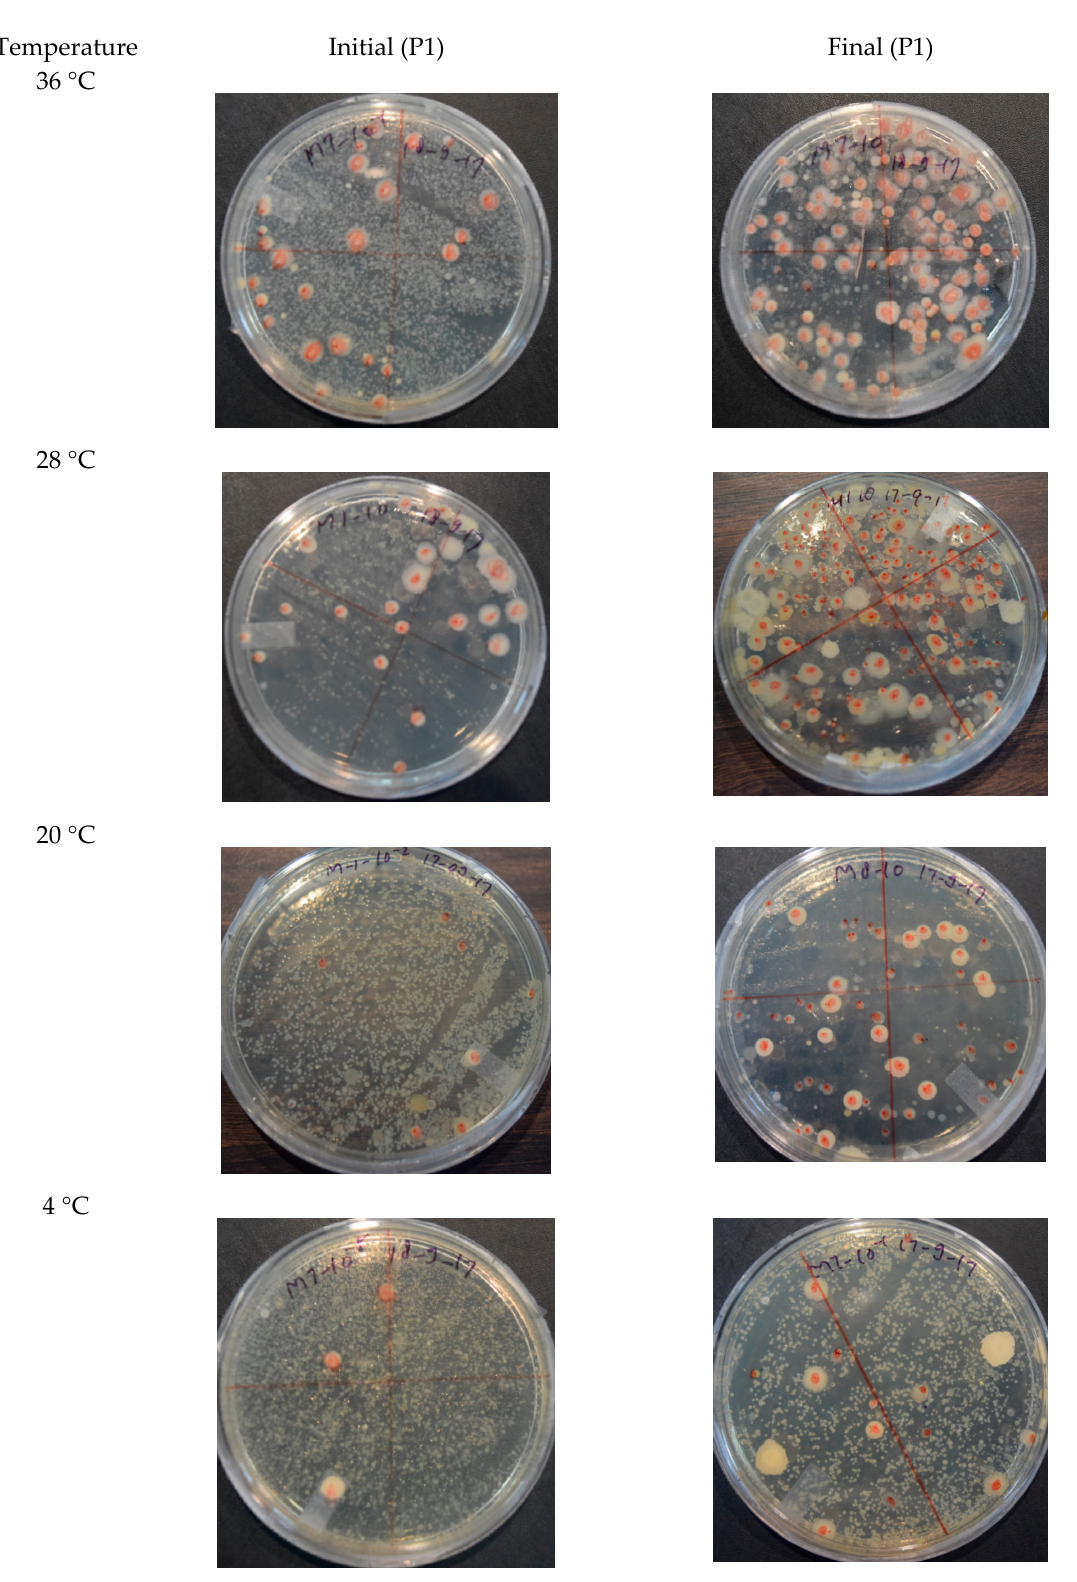
Figure 6. Pictures of Petri plates presenting microbial colony at different temperature levels.